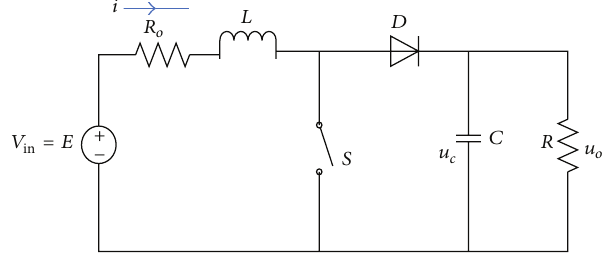
Figure 1: A Boost converter with inductor